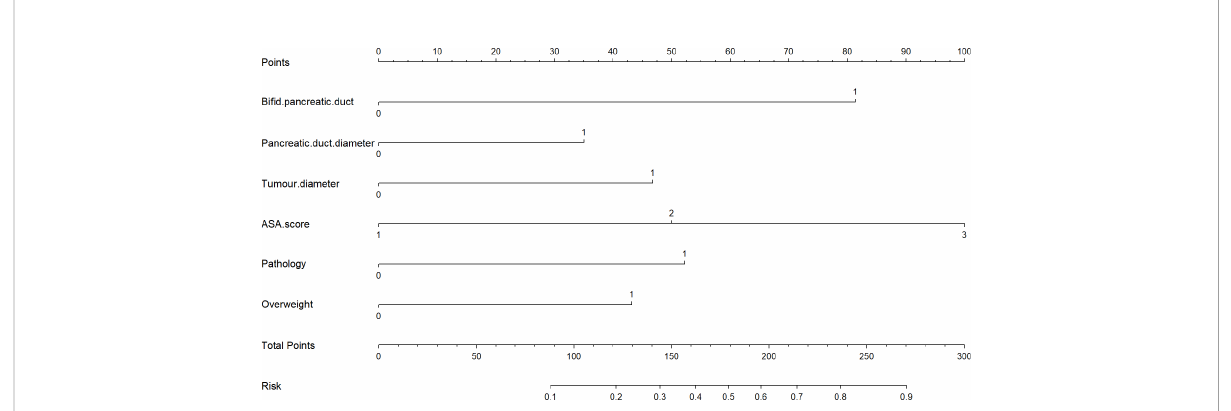
FIGURE 3 A novel nomogram for predicting CR-POPF of patients who underwent pancreaticoduodenectomy. The nomogram is used by adding up the points identi fi ed on the points scale for each variable. According to the sum of these points projected on the bottom scales, the nomogram can provide the incidence of CR-POPF for an individual patient. CR-POPF, clinically relevant postoperative pancreatic fi